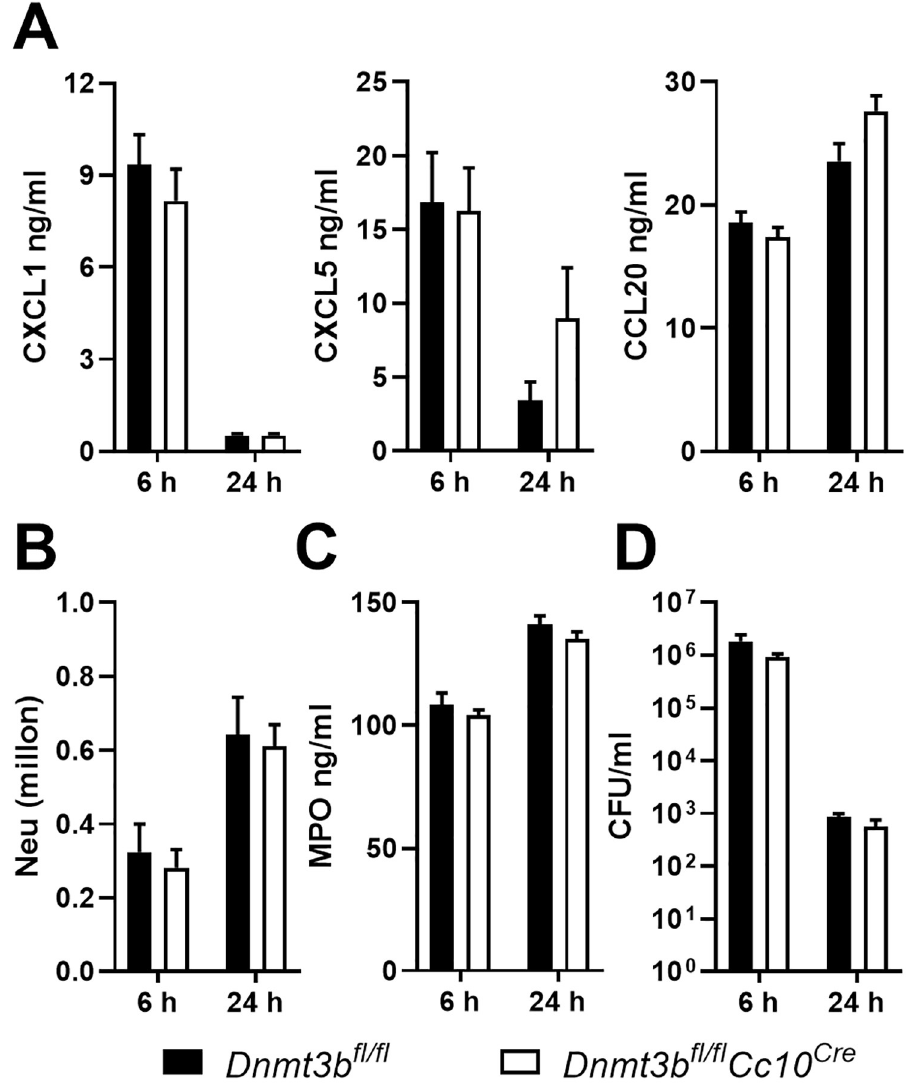
Fig 5. Bronchial epithelial deficiency of Dnmt3b does not modify pulmonary responses during pneumonia caused by flagellin-deficient Pseudomonas . Dnmt3b fl/fl Cc10 Cre and control Dnmt3b fl/fl mice were infected with flagellin- deficient PAK (PAKflic, 5 x 10 6 CFU) intranasally. CXCL1, CXCL5 and CCL20 were determined in BALF harvested after 6 or 24 hours (A). Neutrophil counts (B), MPO (C) and bacterial counts (D) in BALF were determined. Data are presented as means ± SEM of 8 mice per group at each time